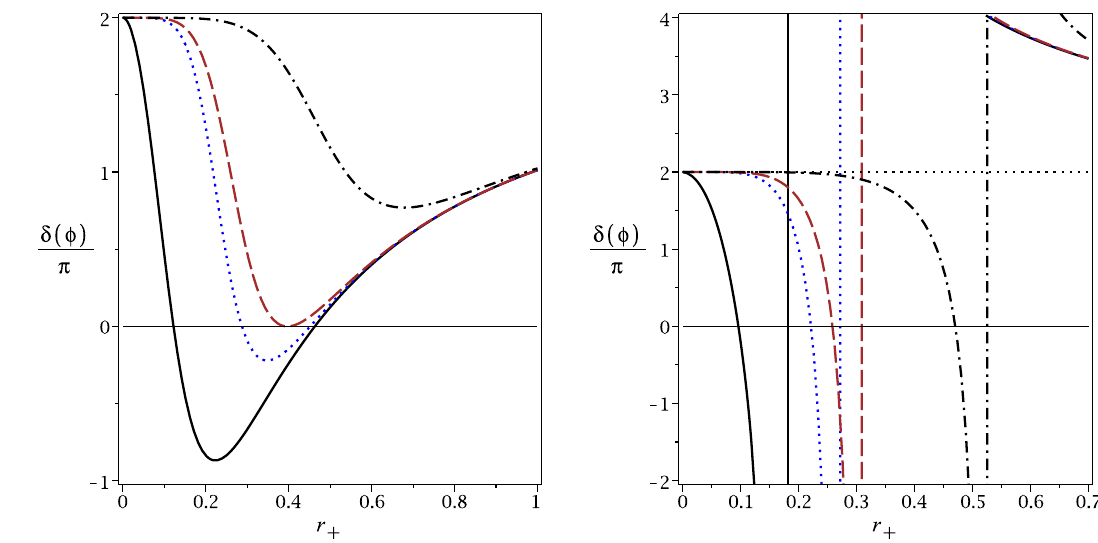
Fig. 2 PMI solutions: δ ( φ ) versus r + for c = c 1 = c 2 = c 3 = c 4 = m = l = 1, d = 5, s = 0 . 9, q = 0 (continuous line), q = 0 . 007 (dotted line), q = 0 . 0122 (dashed line) and q = 0 . 1 (dashed-dotted line). Left diagram: (cid:3) = − 1; right diagram: (cid:3) = 1